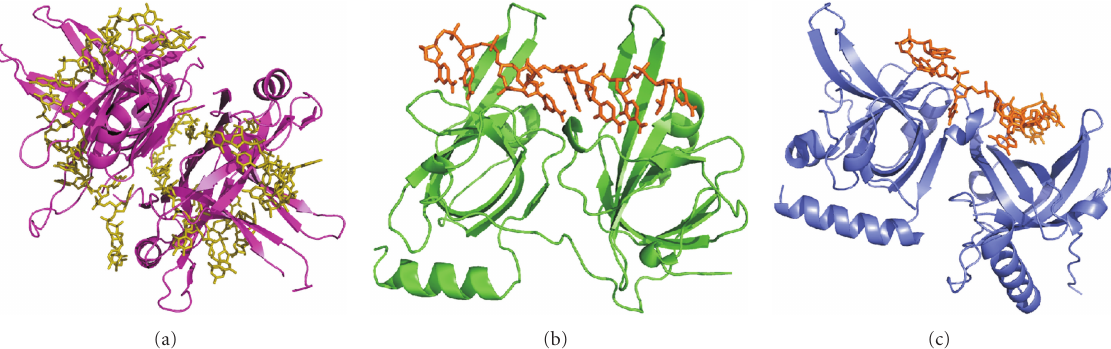
Figure 8: Comparison of the ssDNA-binding interface of OB-fold containing proteins. Proteins are shown as cartoon and ssDNA as stick renderings. (a) Structure of the homotetramer of Ec SSB (1EYG); DNA is shown in gold [31]. (b) Structure of the RPA DBD-A/B (1JMC); DNA is shown in orange [27] (c) Structure of the human Pot1(DBD) (1XJV); DNA is shown in orange [4]. Each structure is shown in the same orientation to highlight the di ff erent ssDNA binding interfaces used by each of these proteins for their specific